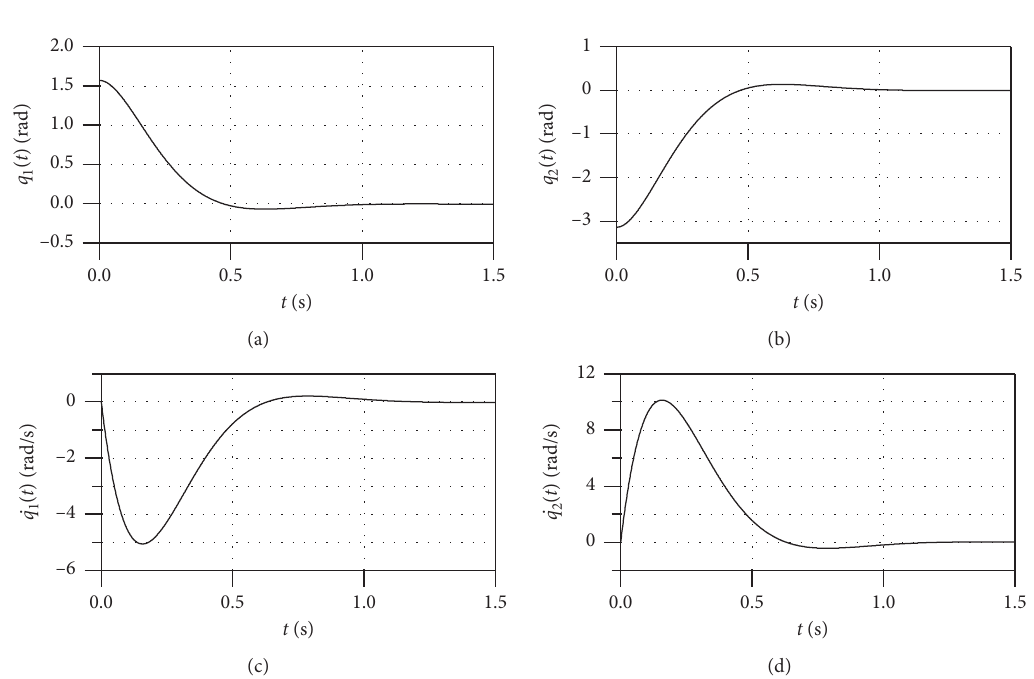
Figure 2: Time response of q